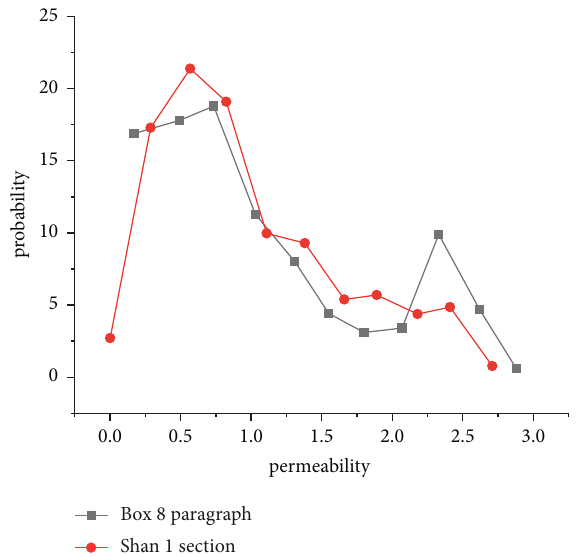
Figure 2: Distribution characteristics of reservoir permeability in the study